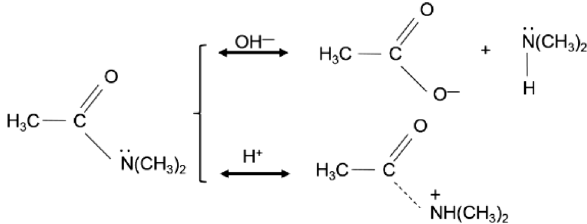
Fig. 8 Conjugate forms of DMAc molecule under alkalinity and acid- ity